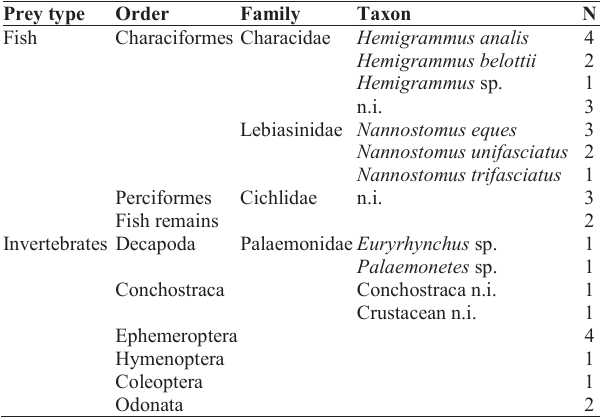
Table 1. Preys consumed by the leaf fish Monocirrhus polyacanthus . Number of stomachs with food = 19; number of preys = 33 (n.i. = not identified).